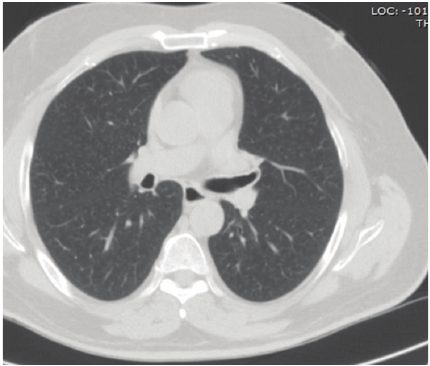
Figure 4: After one-year follow-up, axial noncontrast CT of chest (lung window) showing that the bronchus is still free of masses.